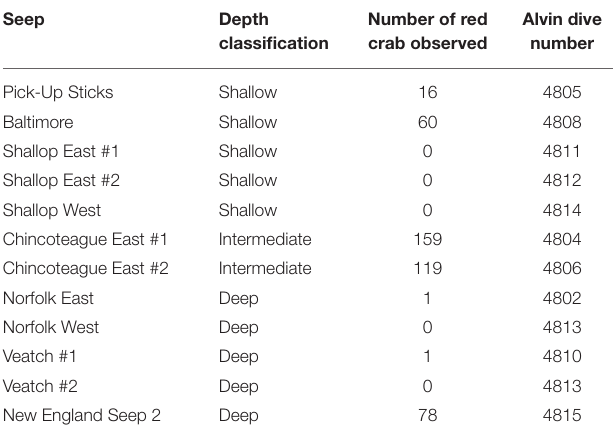
TABLE 5 | Red crab abundance from video